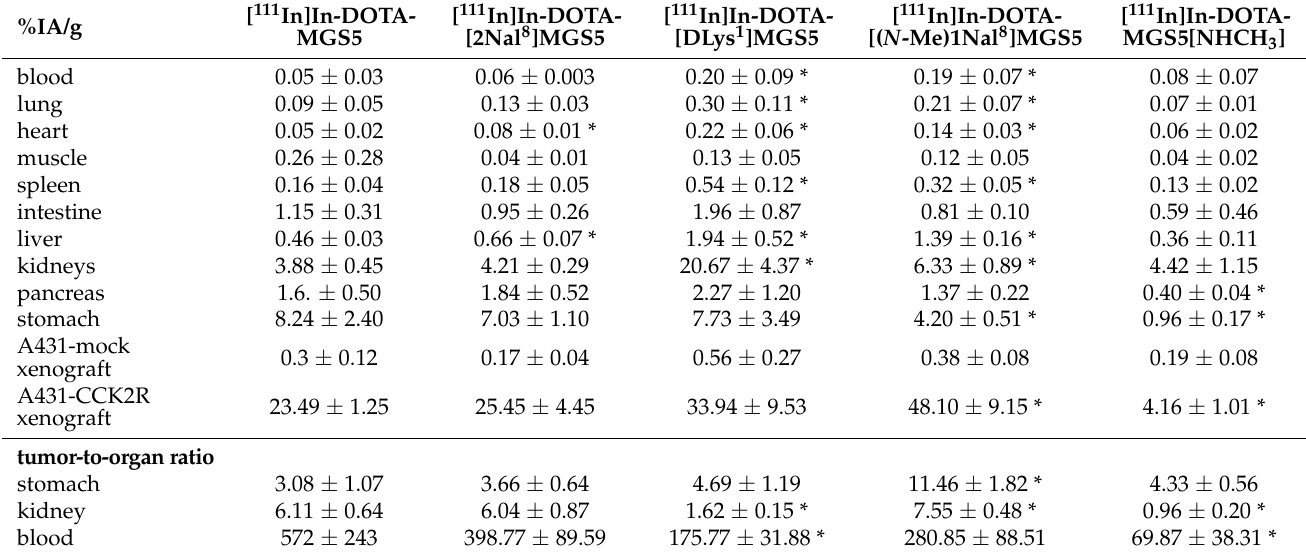
Table 4. Biodistribution and selected tumor-to-organ ratios of the 111 In-labeled peptides in A431-